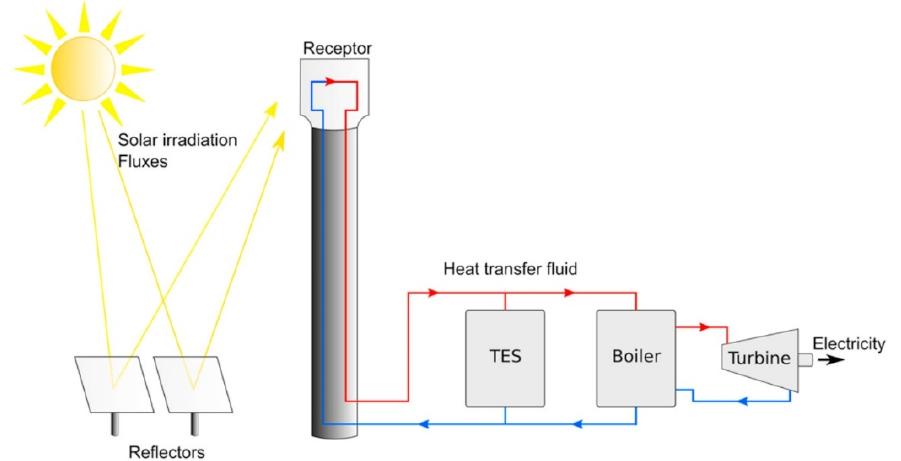
Figure 1. Concentrated solar power plant with thermal energy storage system [5]. TES: thermal energy storage. (Reprint with permission [5]; 2019,